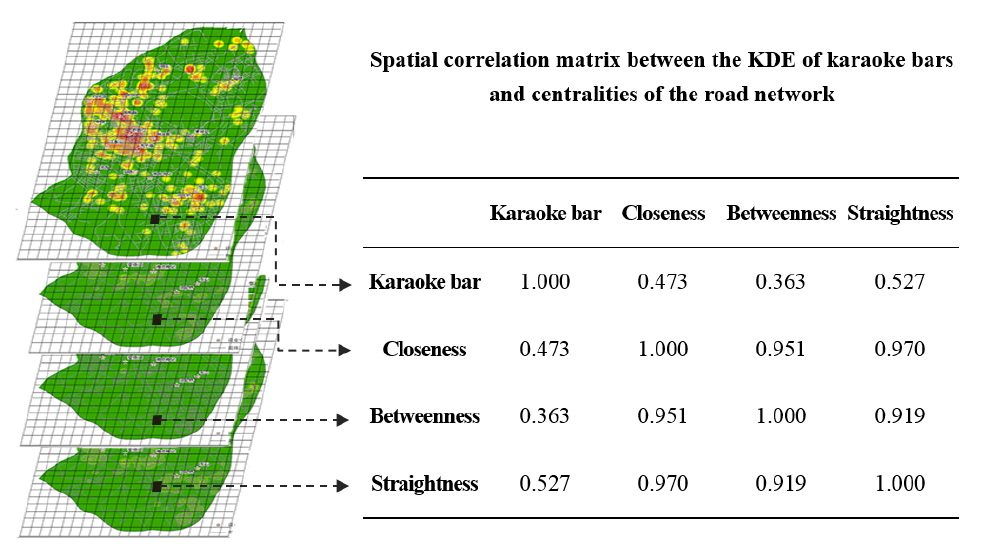
Figure 10. Illustration of raster layers with KDEs.